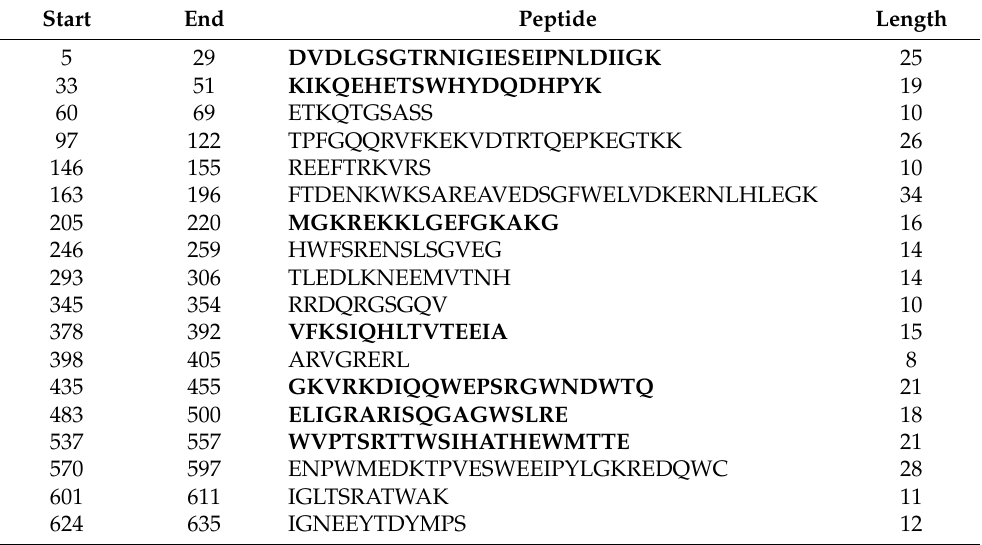
Table 3. The predicted B-cell epitopes derived from the amino acid sequence of Sumatran